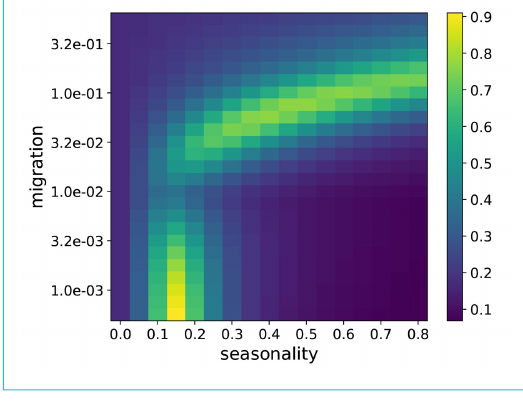
Figure 2: Compatibility of SEIR model trajectories with observa- tions. The heatmap shows the inverse mean squared deviation be- tween the model trajectories and the observed seasonal forcing in seasonal CoV prevalence. Model and observations are compatible (yellow shading) in a region of parameter values corresponding to low migration/weak seasonality and second region at high migra- tion/strong seasonality. Migration refers to the rate per year of a susceptible to return from a abroad with a CoV